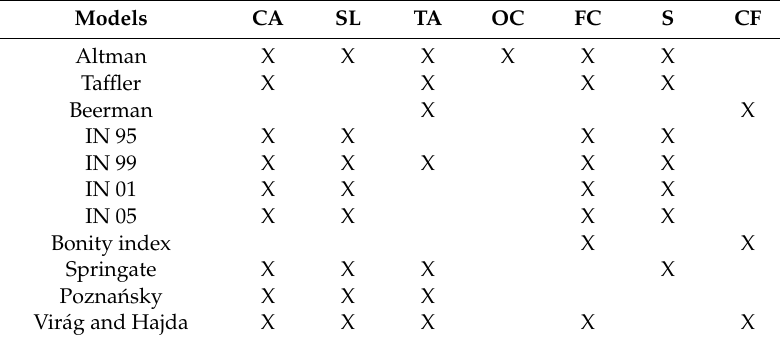
Table 1. Application of selected parameters in multi-discrimination